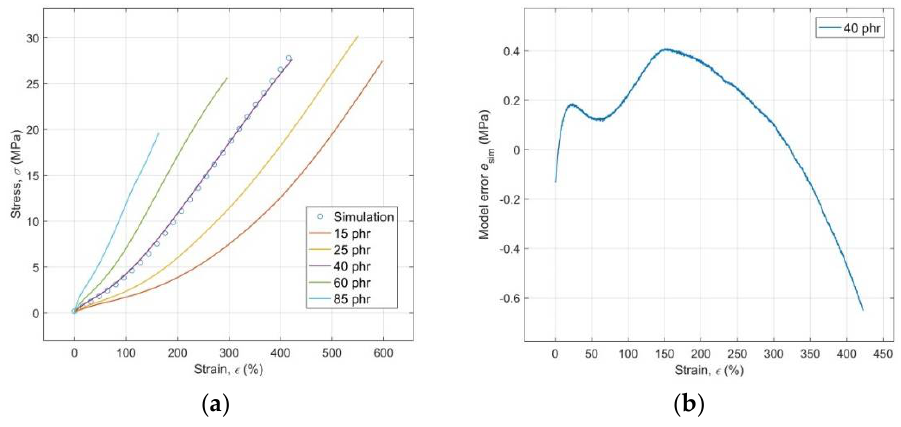
Figure 8. ( a ) Results of simulation of the optimized model with unknown input compared to the experimental stress-strain curves; ( b ) Model error plot of simulated data.